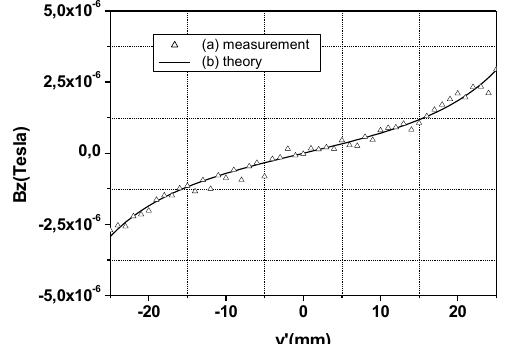
Figure 10: Comparison of the measurement (a) and the theoretical (b) values of 𝐵 in the center of a sane plate !